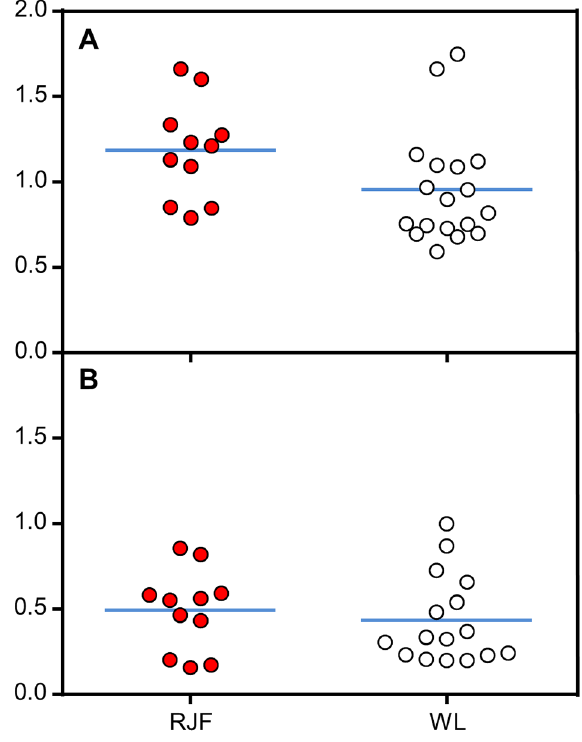
Figure 6. Adrenergic receptor gene expression in adrenal glands. A) ADRA2C and B) ADRA2A where the line indicates average value relative to housekeeping genes and the dots are the individual data